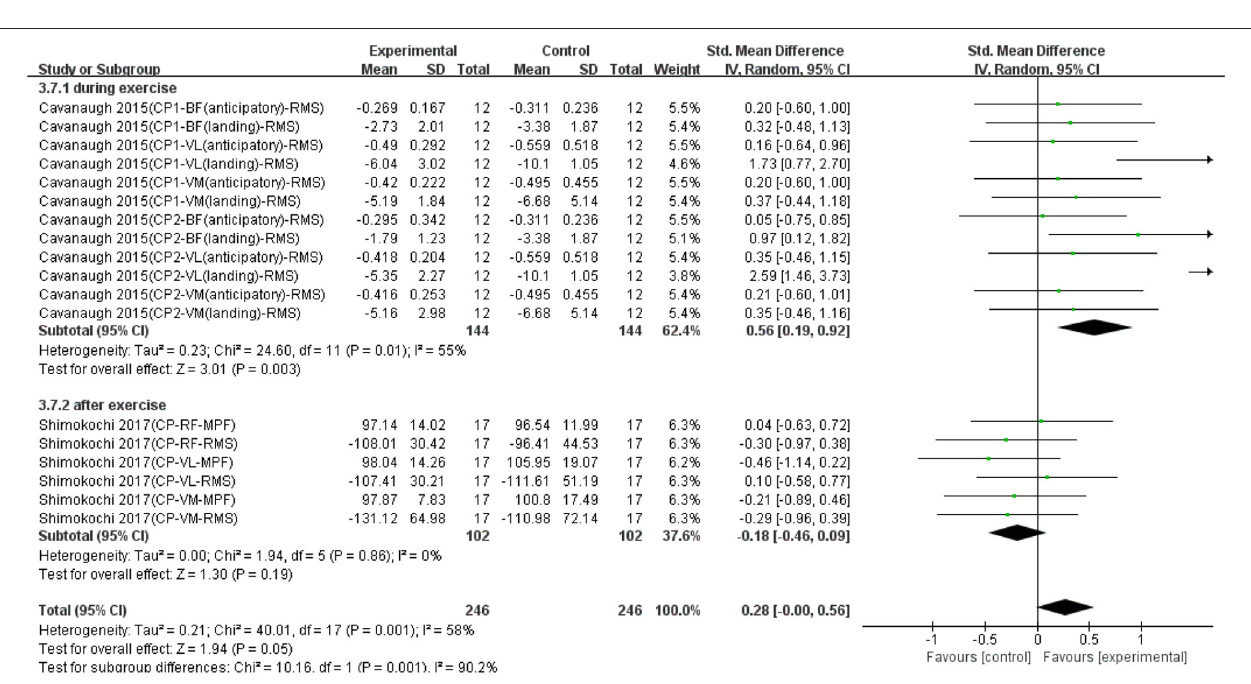
Effect of Massage on Muscle